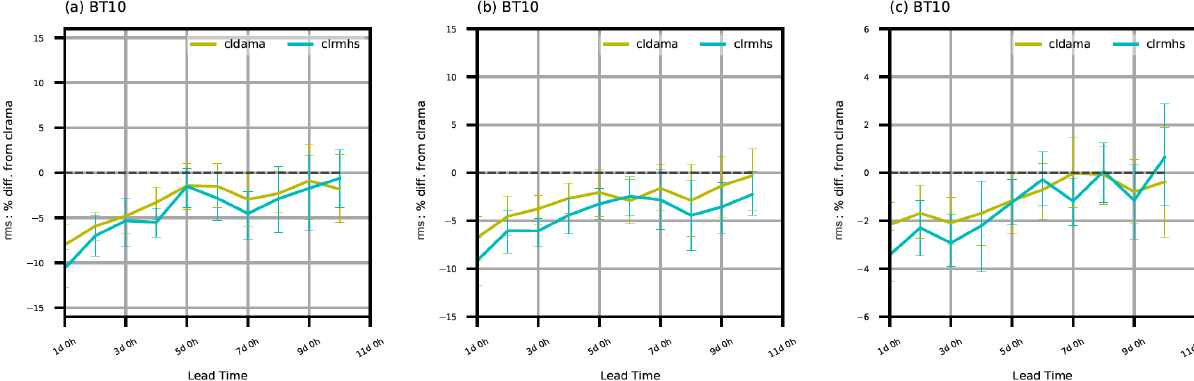
Figure 12. Similar to Fig. 11 but for AHI channel 10’s error statistics over (a) clear, (b) partly cloudy, and (c) fully cloudy pixels, respectively.